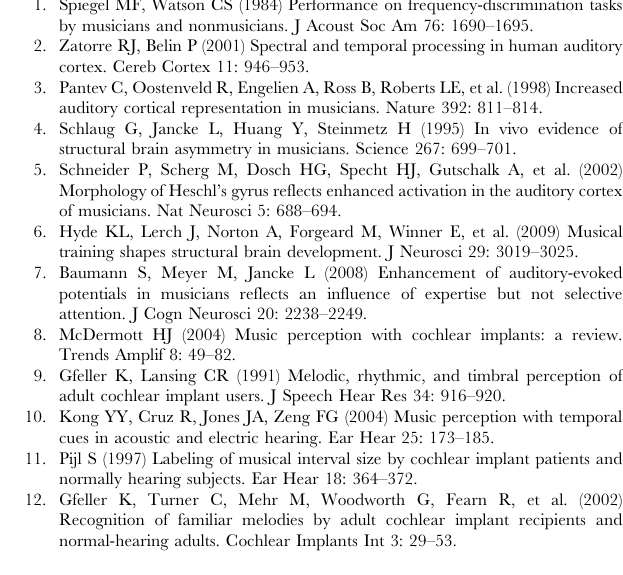
Figure S1 Example of beats produced by interference of two different tones.